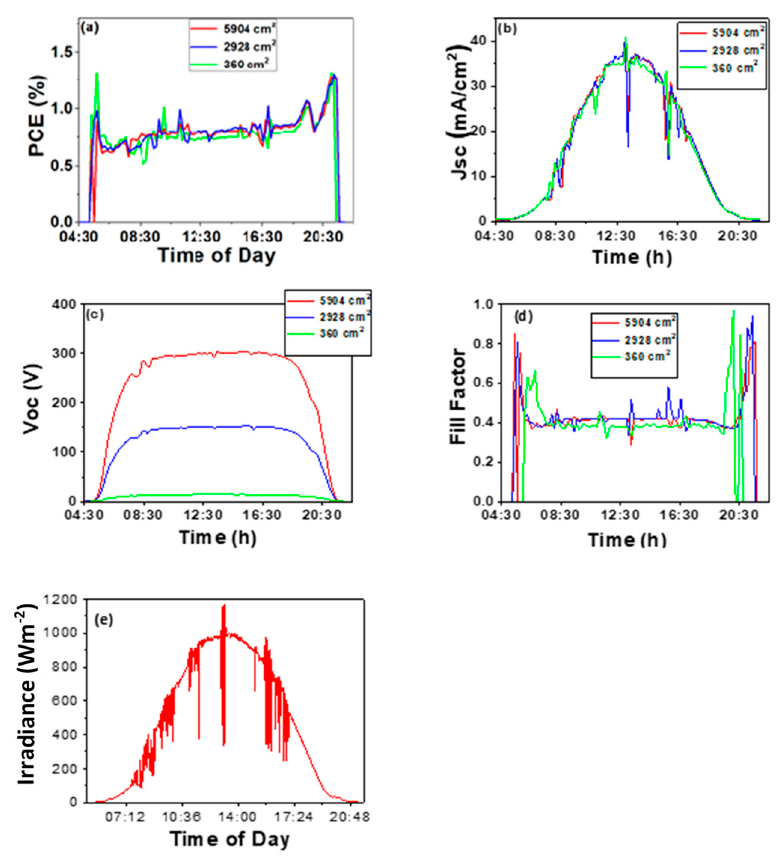
Figure 2. Diurnal variation in solar module parameters ( a ) PCE, ( b ) J SC , ( c ) V OC , ( d ) FF and ( e ) irradiance variation over the course of a sunny day with peak irradiance of approximately 1 Sun for OPVs with three differing module sizes on the 5 August 2018.